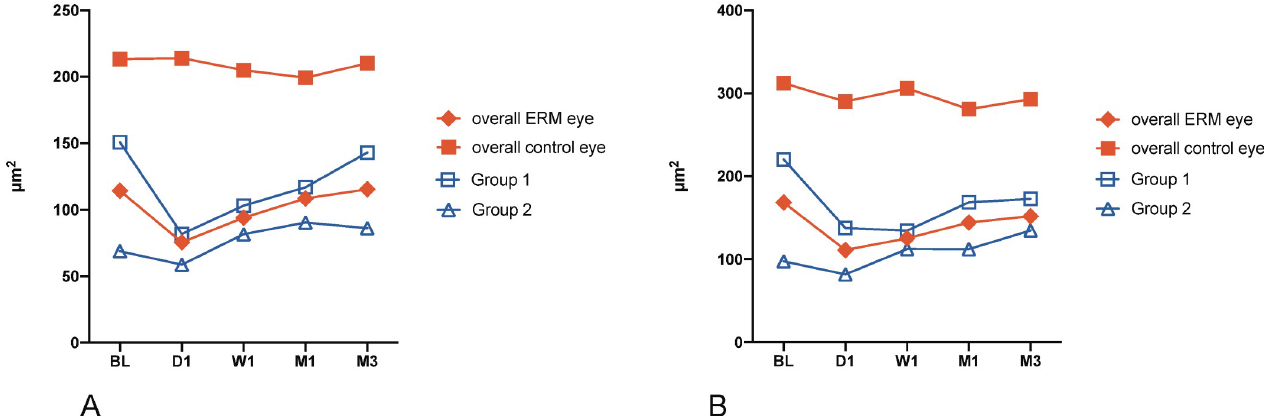
Fig 1. FAZ area of the (A) superficial and (B) deep retinal capillary plexus during the first 3 months after ERM + ILM peeling. Data are presented as the mean; BL = baseline, W1 = week 1, M1 = month 1, M3 = month 3, Group 1 = ERM stages 1 and 2; Group 2 = ERM stages 3 and 4.